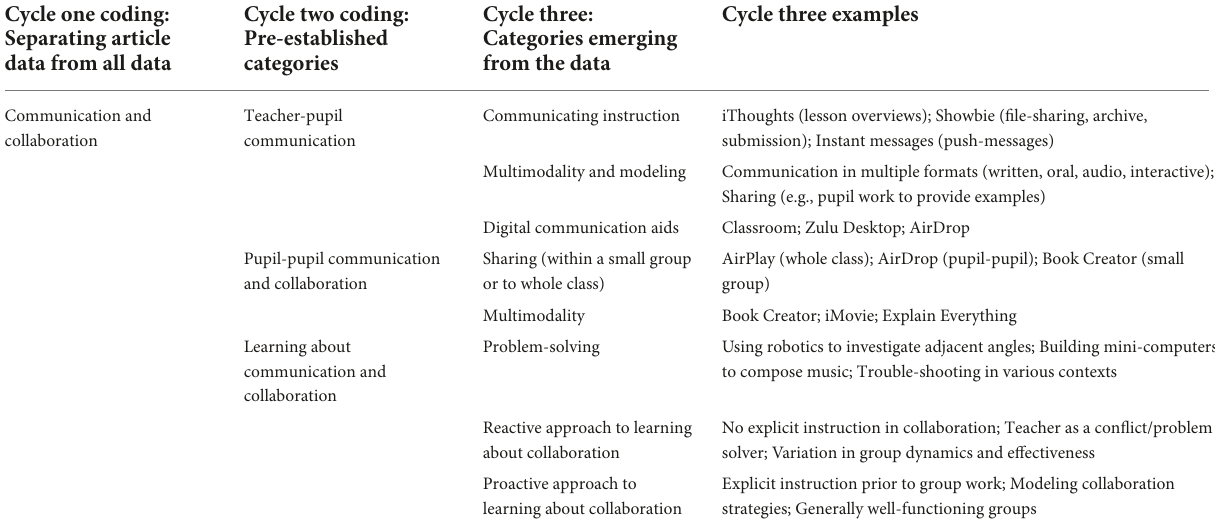
TABLE 1 Cycles of